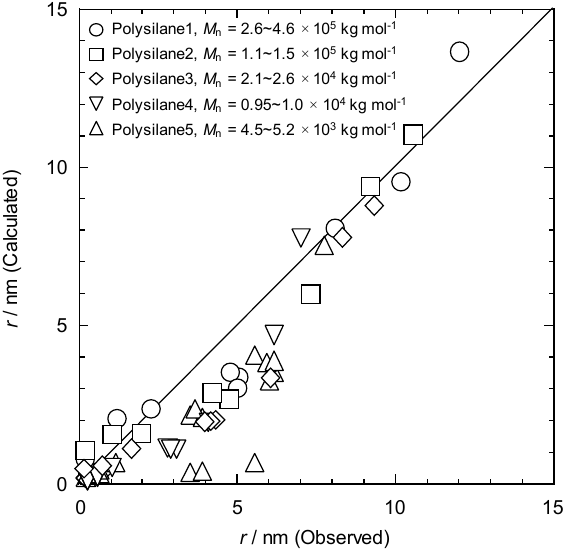
Figure 2. Correlation between r values estimated experimentally by gel traces or direct AFM measurement and the ones by theoretical calculations with Equation (43). Reproduced with permission from ref. [78] © 2005, American Chemical Society.